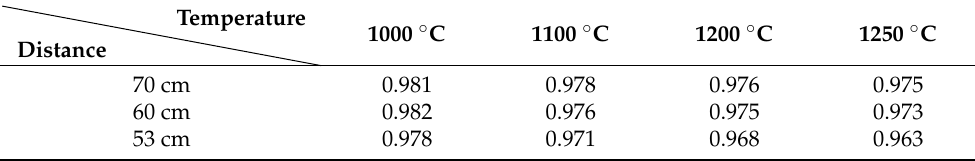
Table 4. Evolution of emissivity of the 8YSZ ceramic coating with temperature.